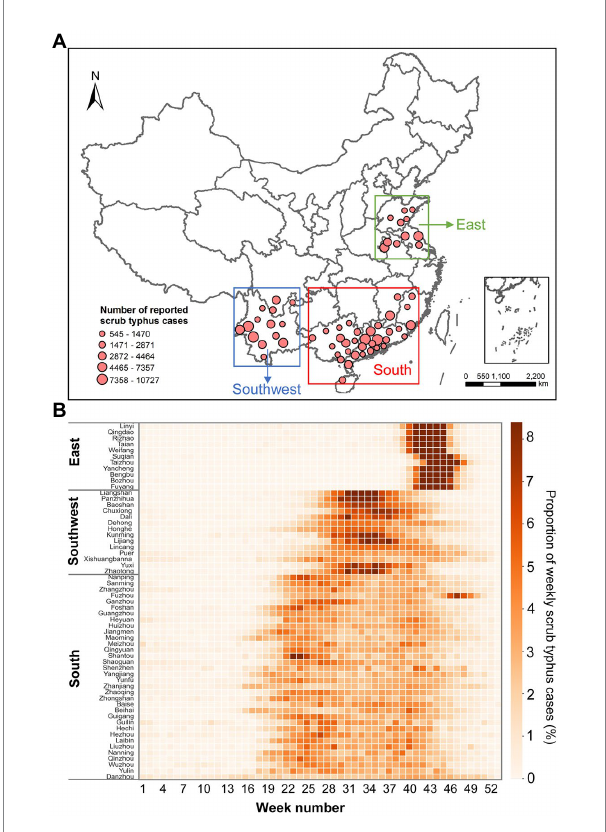
FIGURE 1 (A) Geographic locations of the 59 prefecture-level administrative regions included in the study and the total reported scrub typhus cases during 2006–2020. (B) Seasonal characteristics of scrub typhus cases. Each cell denotes the proportion of weekly scrub typhus cases out of the total scrub typhus